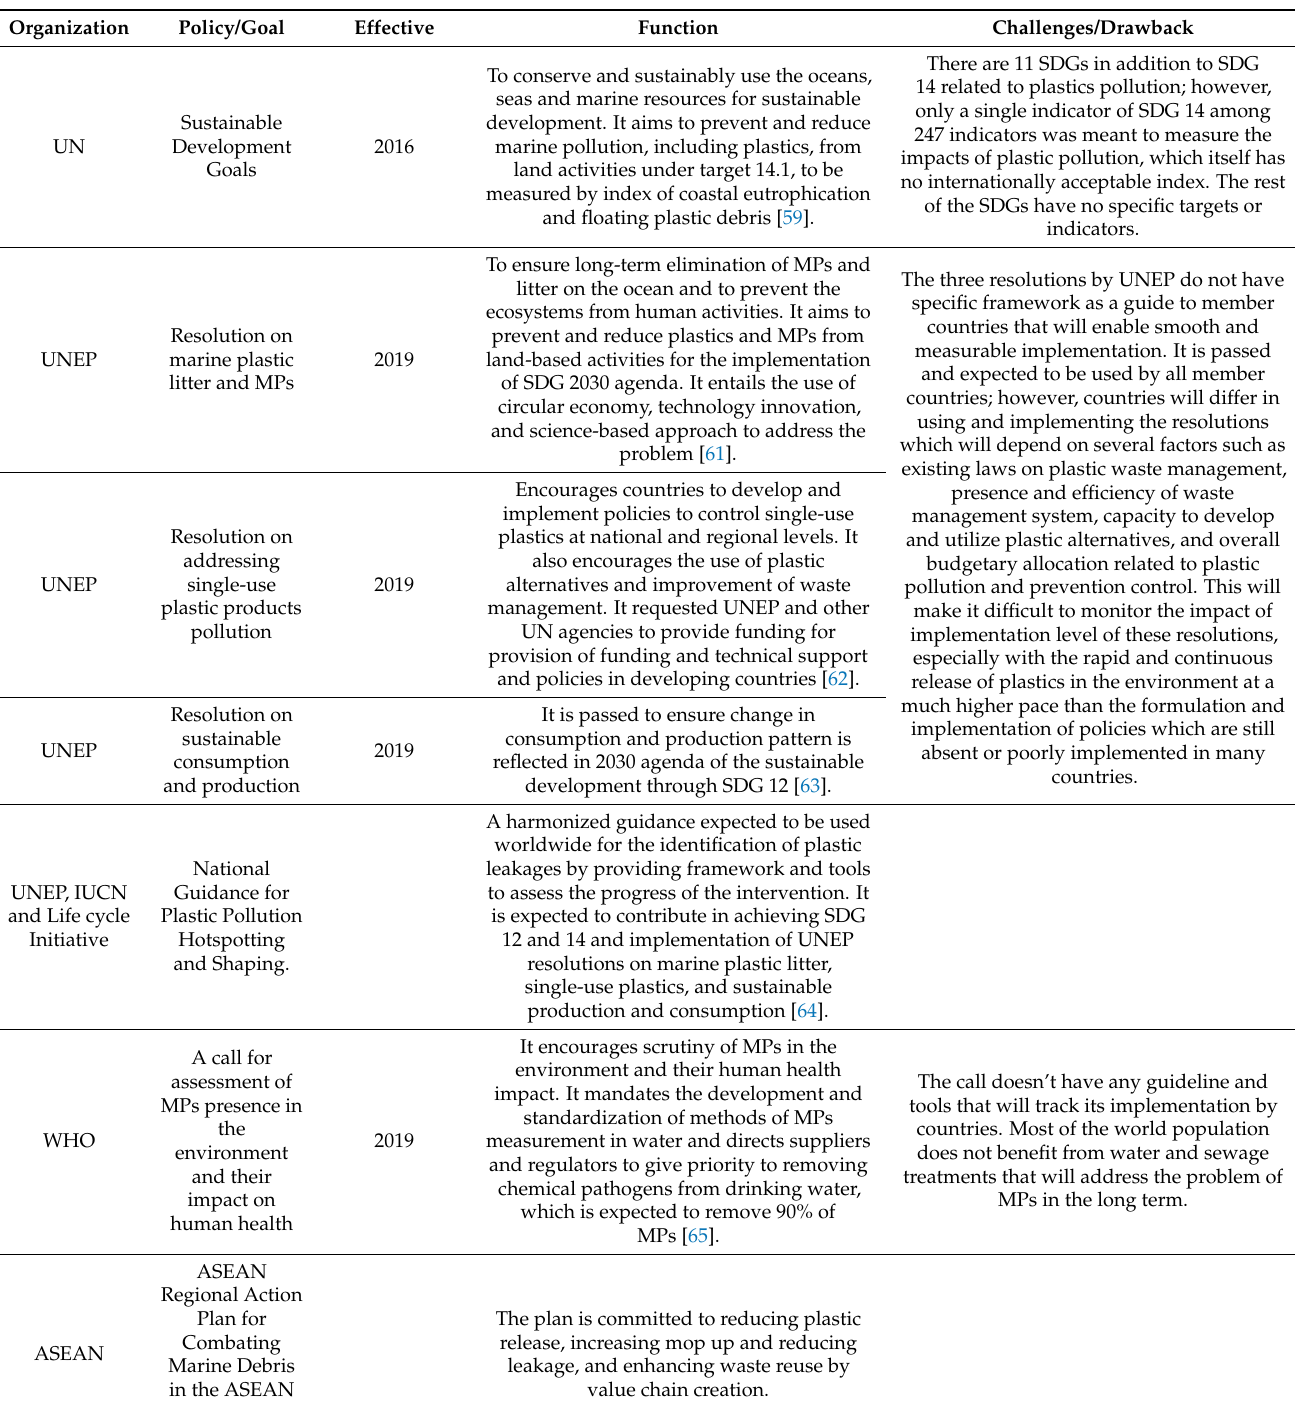
Table 3. Policies and regulations on plastics by international organizations with associated